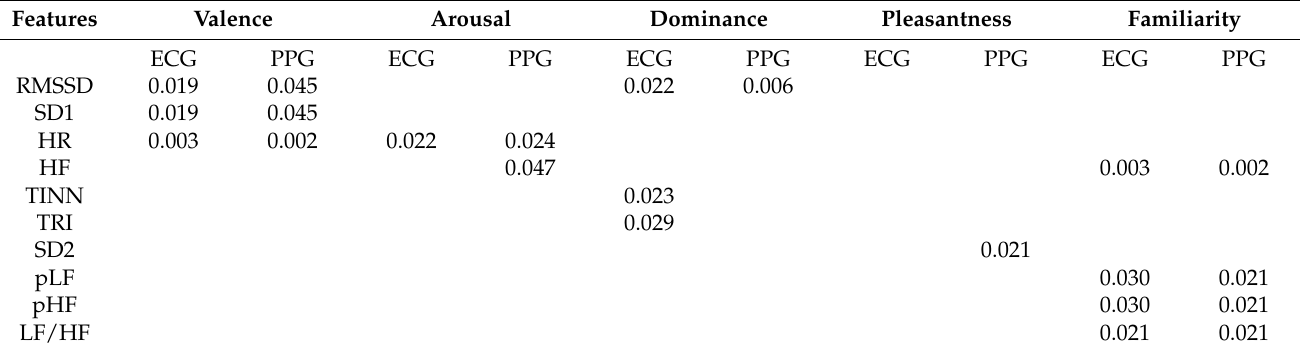
Table 5. One-way ANOVA analysis of binary classes.